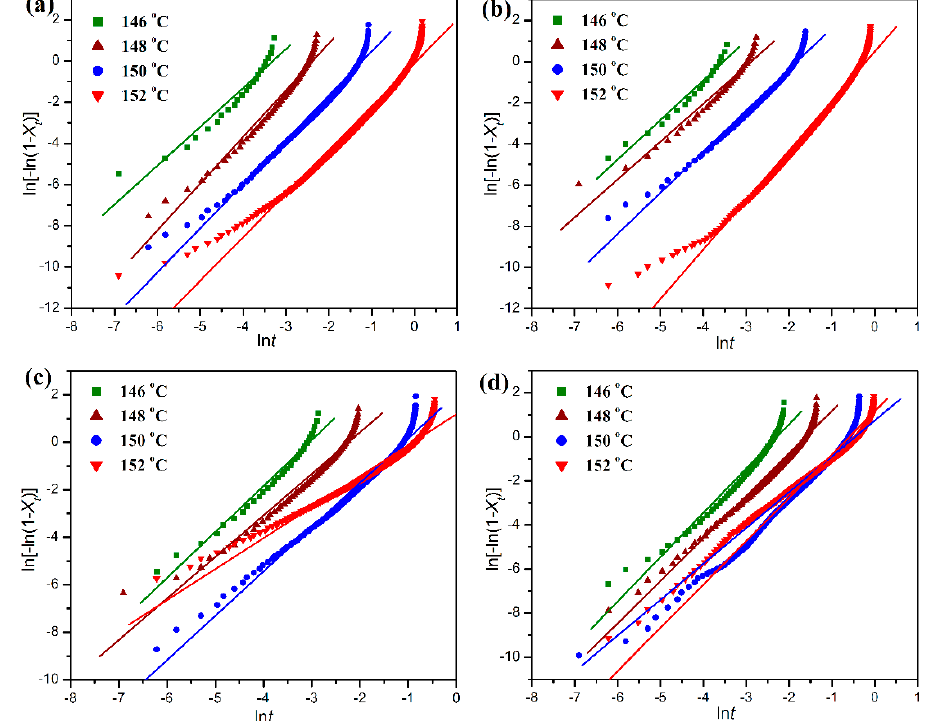
Figure11. Avramiplotsofln[ − ln(1 − X t )]versusln t fortheisothermalcrystallizationof( a )purePOMand its blends with ( b ) 10 wt %, ( c ) 20 wt %, and ( d ) 40 wt % of PLA at di ff erent crystallization